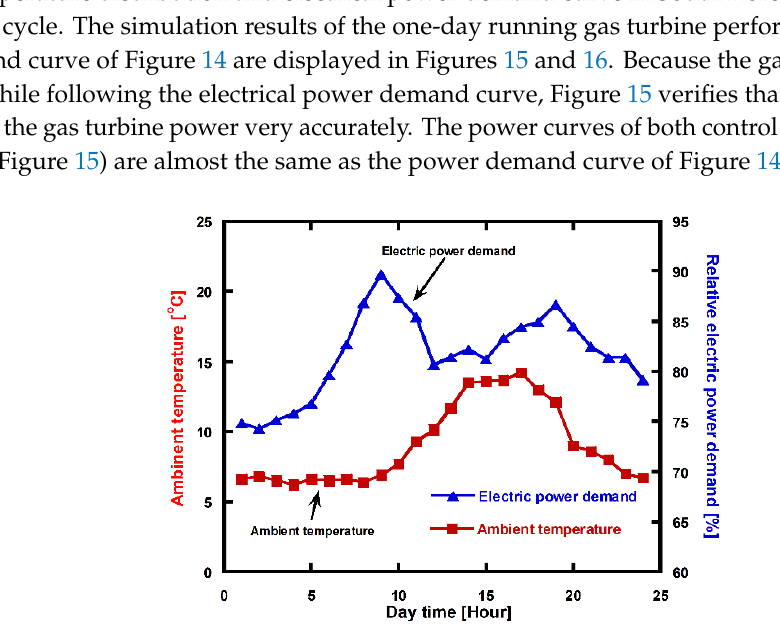
Figure 14. Example of the variations in ambient temperature and electric power demand during a spring day in South Korea.